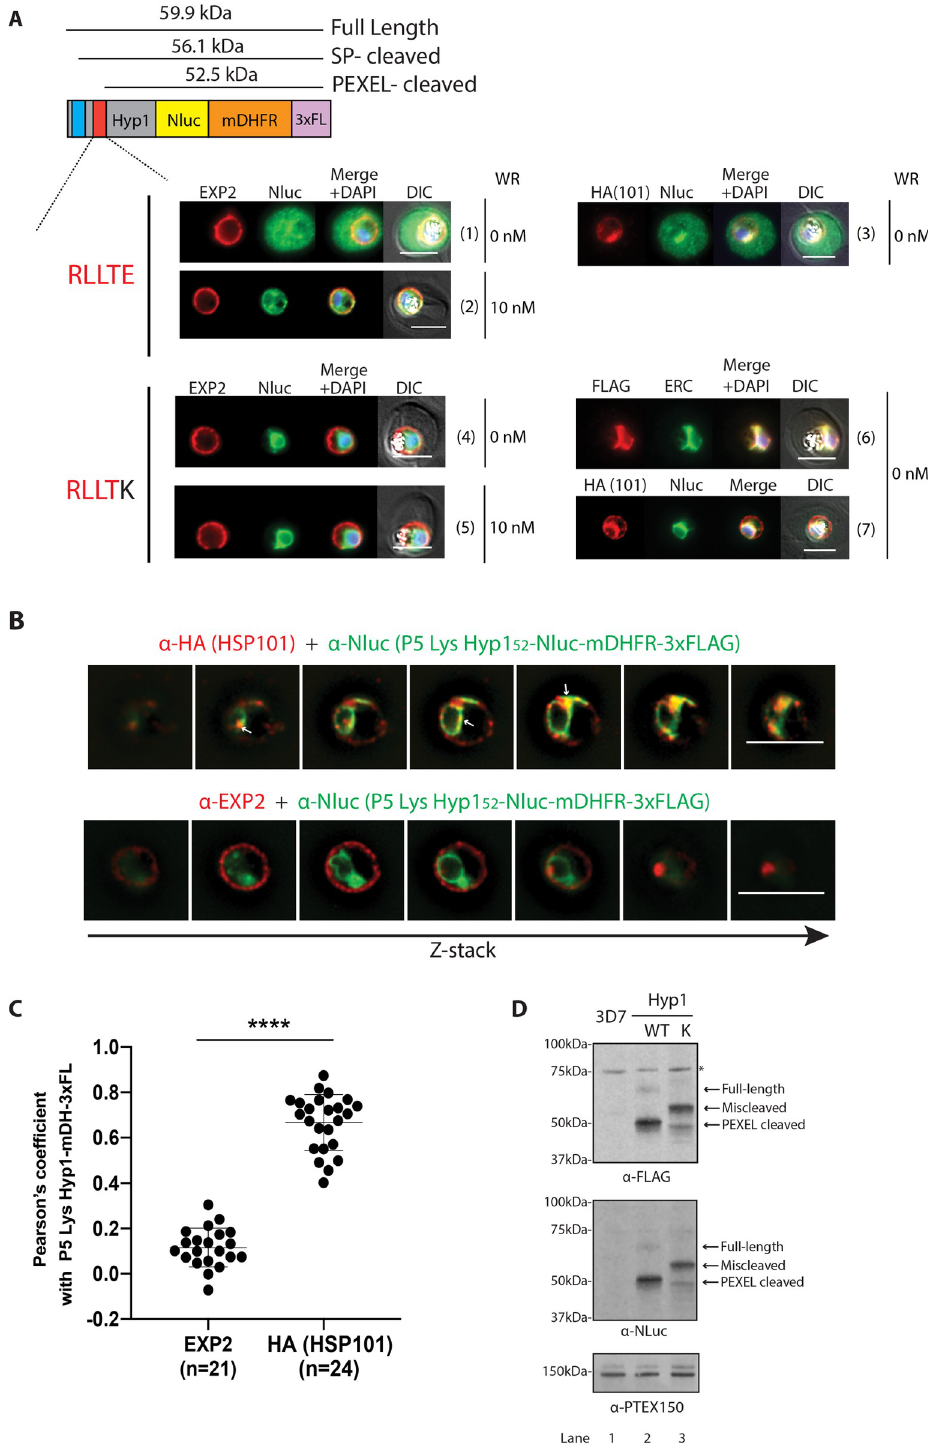
Fig 5. Intra-parasite HSP101 co-localises with P5 Lys Hyp1-Nluc-mDHFR-3xFLAG reporter construct in the endoplasmic reticulum of the parasite. (A) Representative IFA images (n = 3 independent replicates) of parasites expressing Hyp1-Nluc-mDHFR-3xFLAG constructs with WT P5 glutamate reporter exported into the erythrocyte and the mutant P5 Lys Hyp1-Nluc-mDHFR-3xFLAG reporter trapped in the parasite ER. To visualise translocon components, cells were probed with anti-EXP2 and anti-HA (to visualise HA-tagged HSP101). Anti-PfERC was